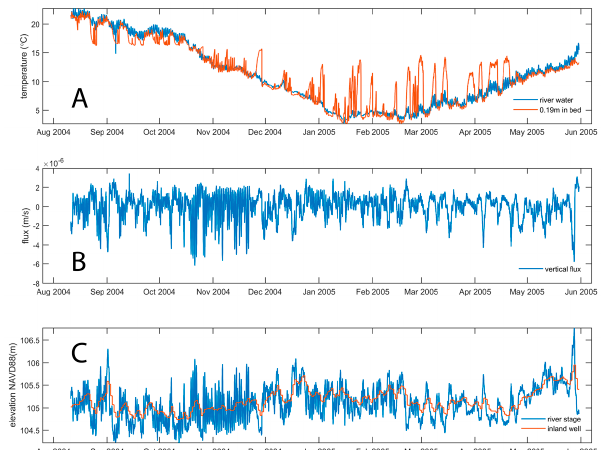
Figure 3. Temperature data collected from Spring 9 ( A ); estimated cross-bed flux rates based on piezometer data and Darcy’s Law ( B ); and river stages and associated inland well water levels during the same period ( C ).